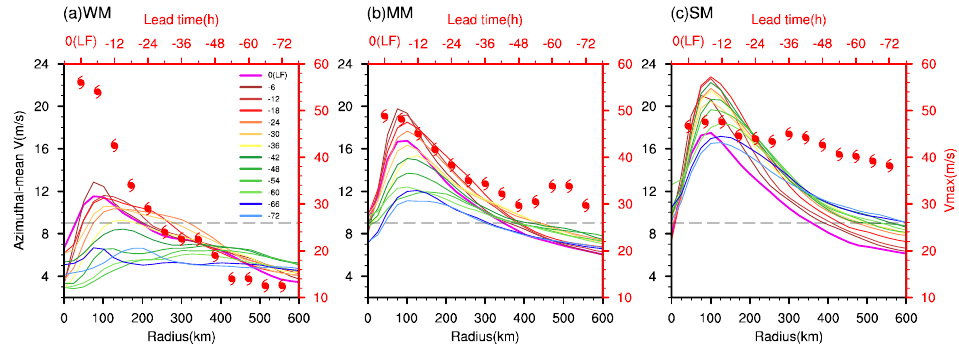
Figure 3. Dynamic composite of the 10 m azimuthal-mean wind speeds (solid lines, m s − 1 ) and typhoon intensity (the red typhoon labels, m s − 1 ) from 72 h before landfall to landfall (LF). ( a ) Cluster WM, ( b ) cluster MM, ( c ) and cluster SM. The horizontal dash lines reveal the 9 m s − 1 10 m wind speeds. The bottom, upper, left, and right axes indicate the distance from TC center, the lead hours before TC landing in SC, the 10 m azimuthal-mean wind speeds, and TC intensity, respectively. Information for wind speed (TC) should refer to the bottom and left (upper and right) axes. Negative values in label legends and the upper axis indicate the hours before TC landing in SC.